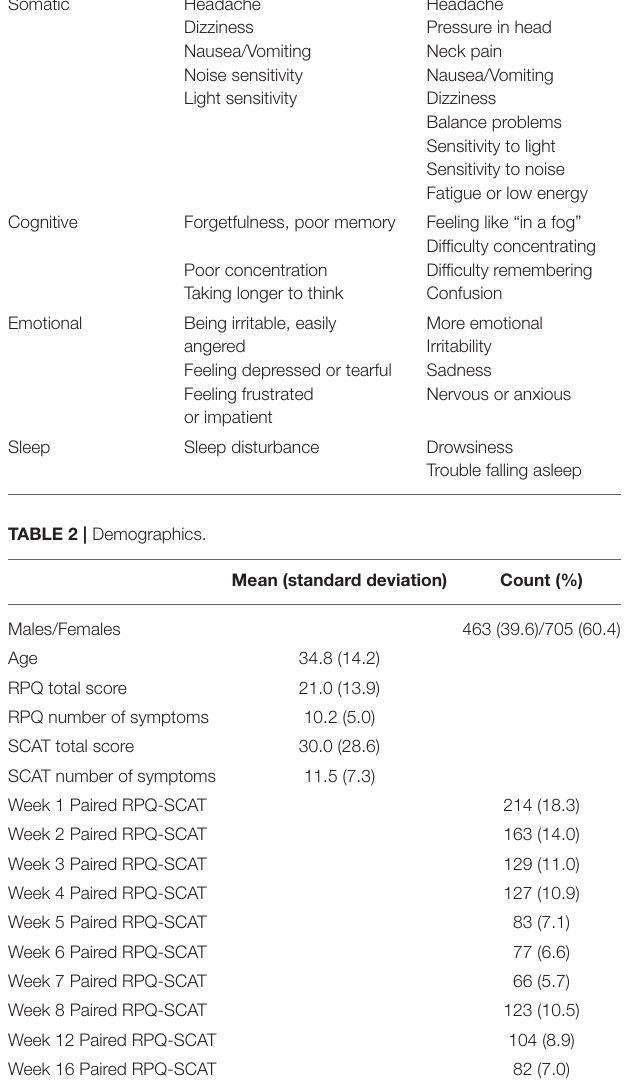
week are presented in Table 3 . The correlation between the total scores on both measures remained very strong over